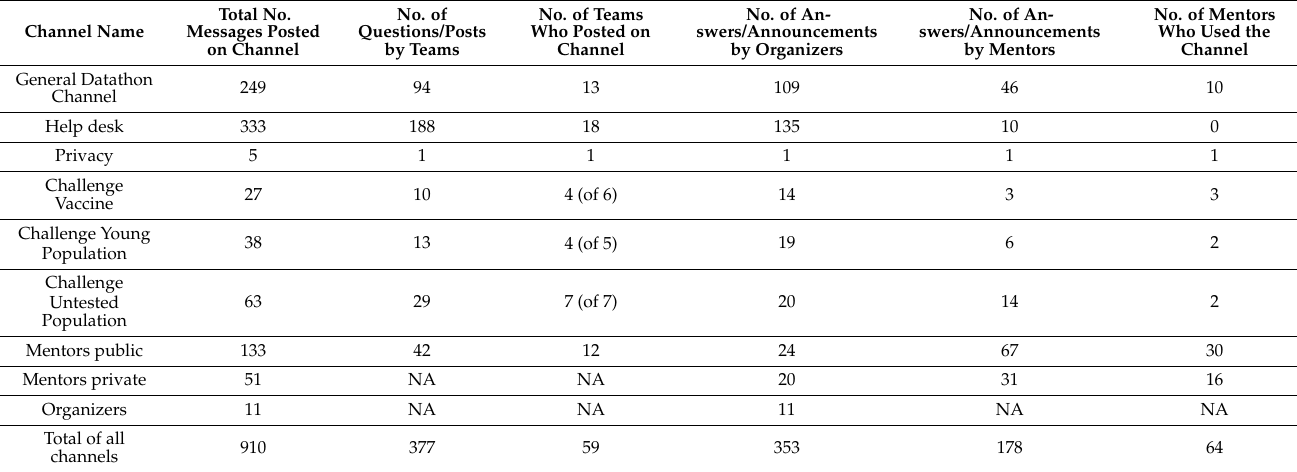
Table A3. Communication between Team Members, Mentors, and the Organizing Committee Via